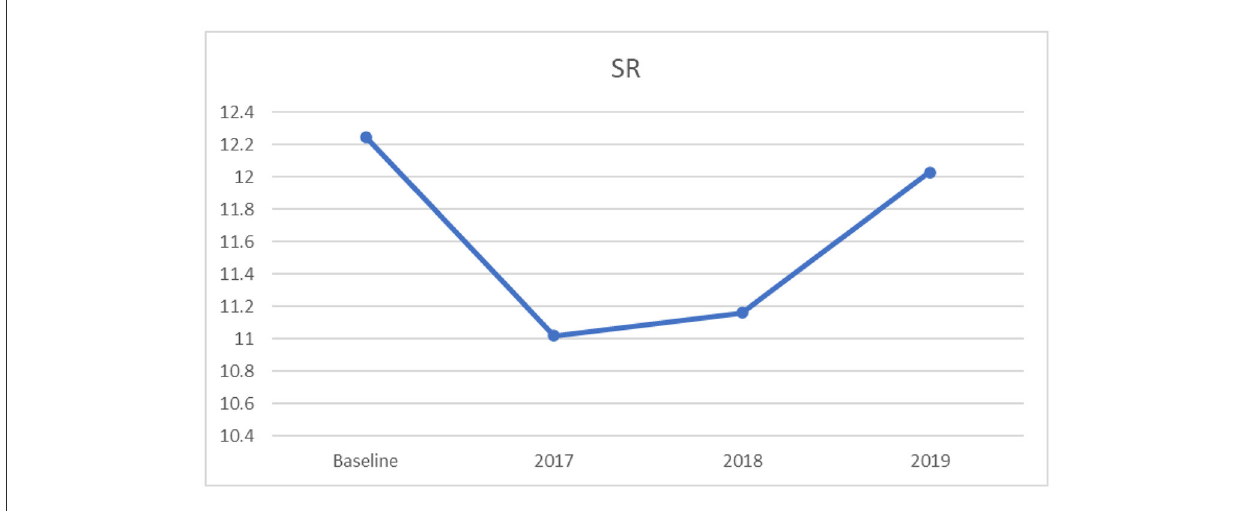
FIGURE4 Mean sit-and-reach scores: across baseline and years 2017–2019.